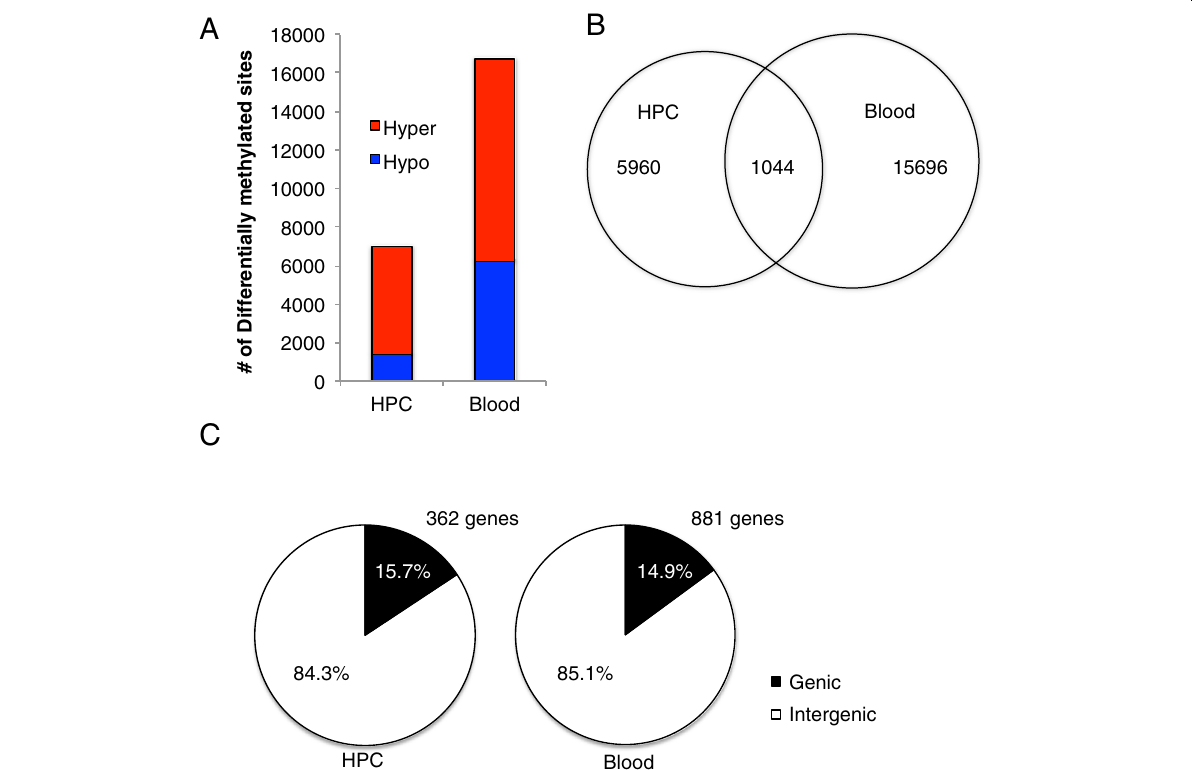
Fig. 1 Overview of differentially methylated CpG (DMCs) in the hippocampus (HPC) and whole blood in female offspring born to mothers that received synthetic glucocorticoids (sGC) during pregnancy compared to saline controls. A Bar graphs illustrating the number of DMCs for the HPC and whole blood. Red bars: the number of DMCs that were hypermethylated in the sGC condition compared to controls. The blue bars: hypomethylation in the sGC condition compared to controls. B Venn diagram illustrating the number of the DMCs in each tissue and at the same CpG locations in both the HPC and blood. C Pie charts illustrating the proportion of genic (in black) vs intergenic (in white) DMCs in the HPC and whole blood. The number of genes associated with DMCs is shown for each tissue. DMCs were de fi ned as signi fi cant at FDR P < 0.05 and 5% minimum methylation